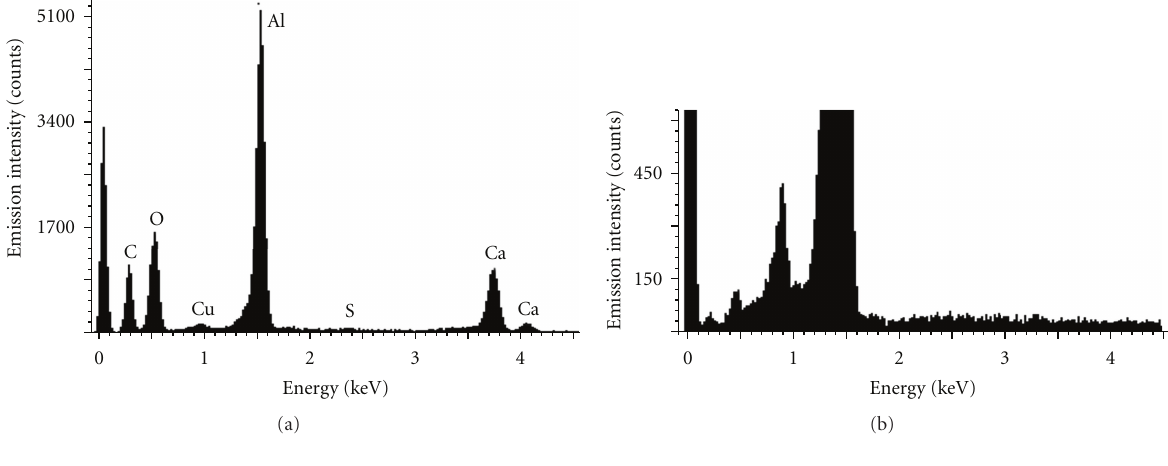
Figure 2: Energy dispersive X-ray spectrum (EDS) of a needle (a) and stub (b). Emission intensity (counts) is plotted versus energy (keV) characteristic for various elements (Al: aluminum; C: carbon; Ca: calcium; Cu: copper; O: oxygen; S: sulfur).